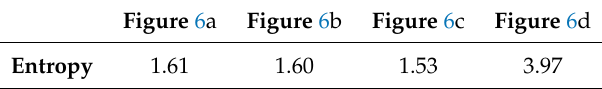
Figure 6. ISAR images obtained by Algorithm 2 using different number of pulses. ( a – d ) corresponding to results from 64, 32, 16, 8 sampled pulses, respectively. Table 2. Entropies of the imaging